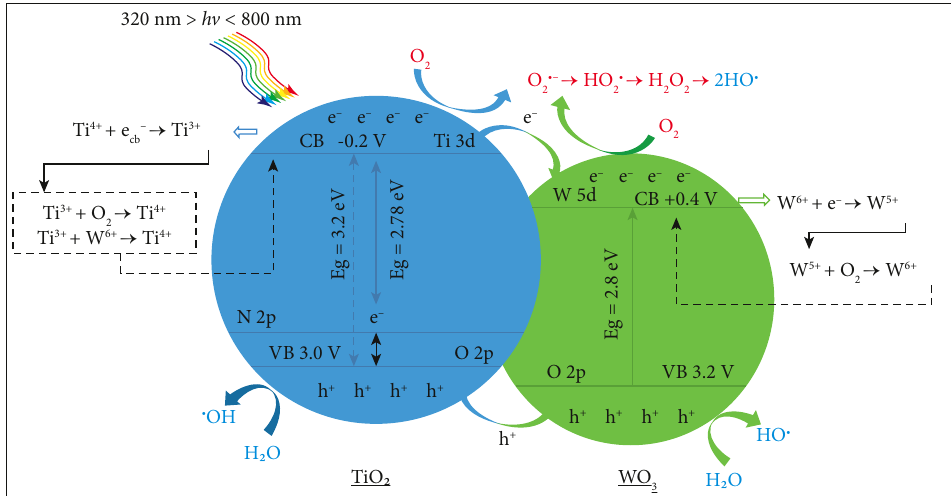
Figure 3: WO 3 /TiO 2 composite film